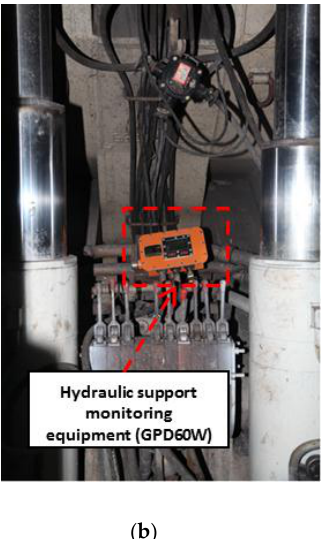
Figure 8 . Monitoring design of the 8304 longwall working face: ( a ) Monitoring scheme; ( b ) Monitoring equipment (GPD60W).